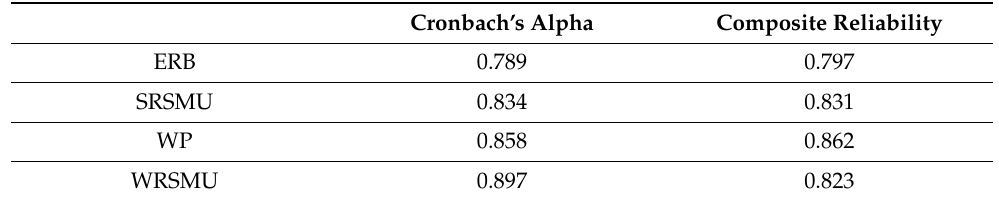
Table 3. Internal consistency